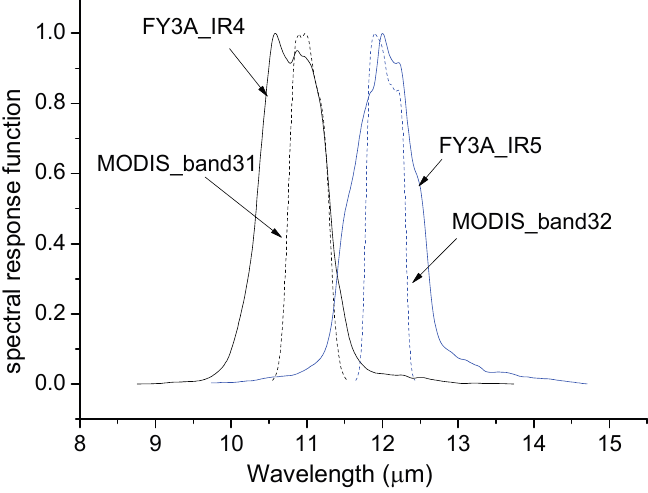
Figure 2. Spectral response functions of FengYun-3A (FY-3A) VIRR Channels 4 and 5 and MODIS Channels 31 and